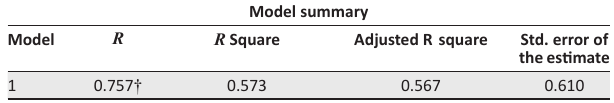
TABLE 3a: Multiple regression analysis.